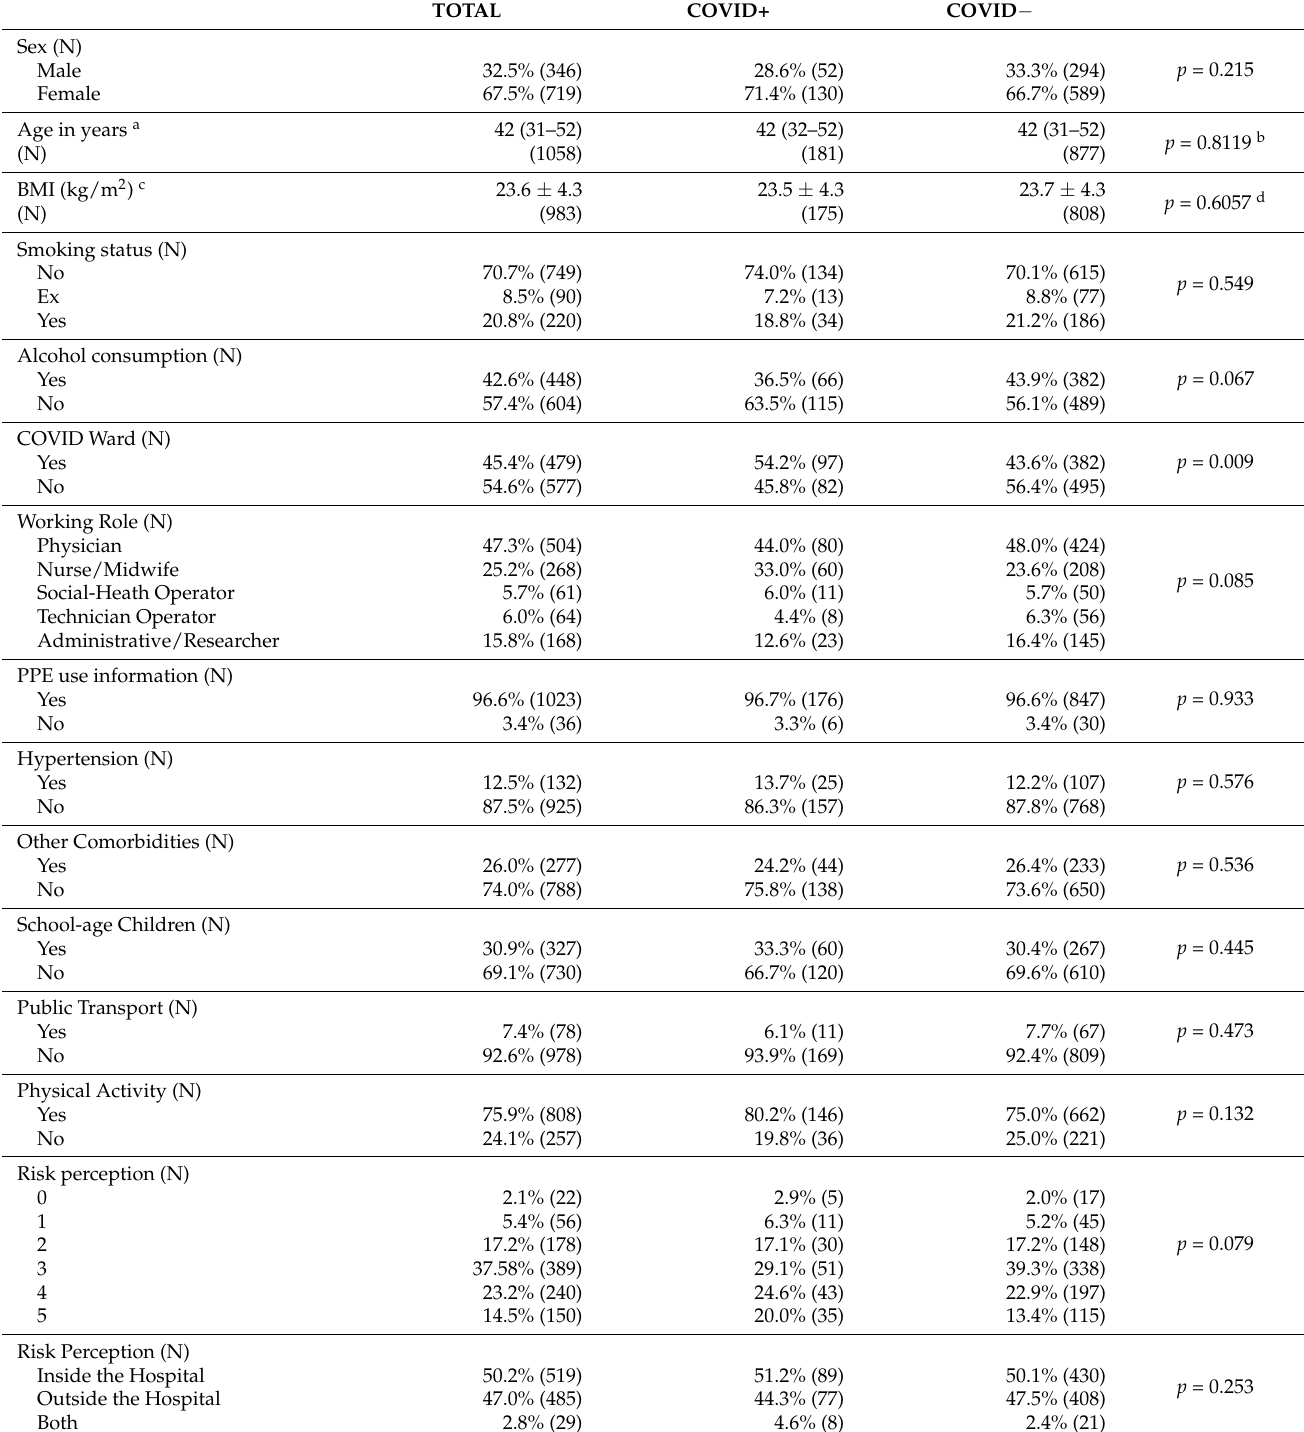
Table 1. Characteristics of IRCCS Policlinico San Matteo hospital